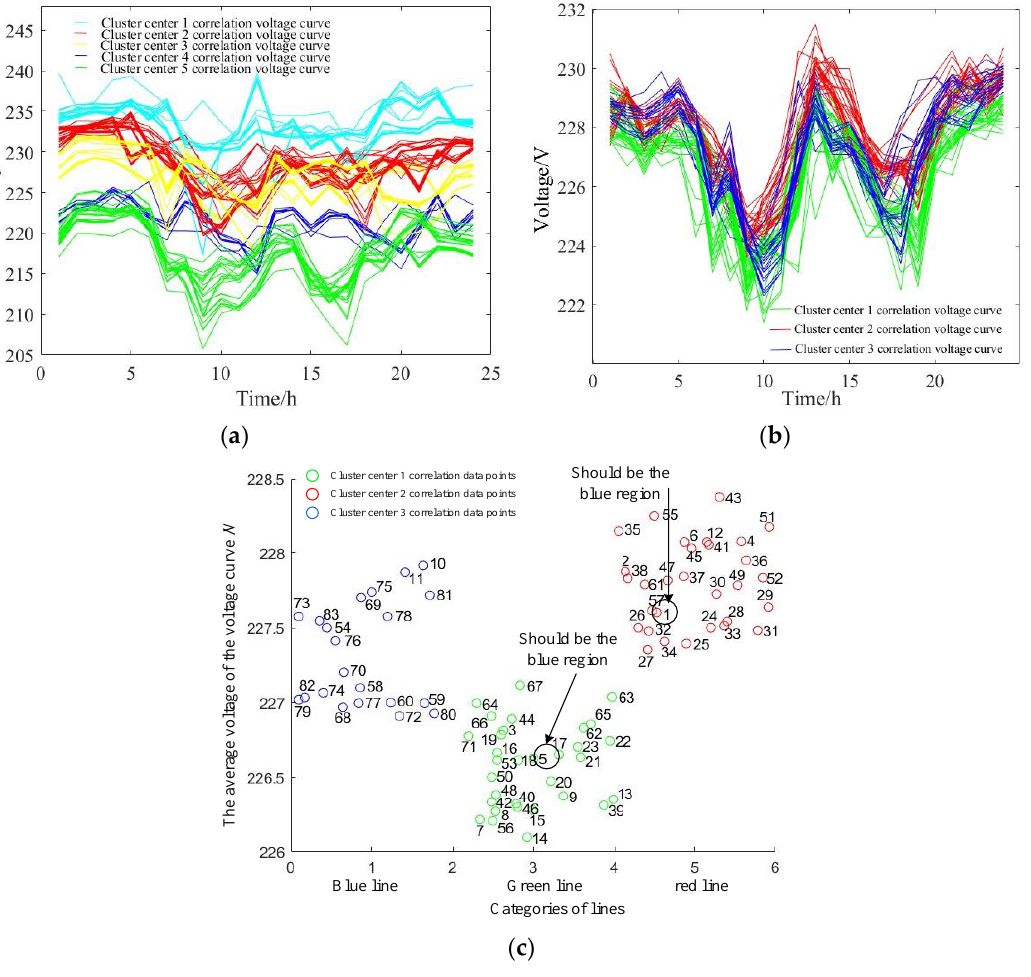
Figure 10. Analysis chart of voltage data in the missing region of the station area: ( a ) Voltage variation curve of users in the missing area after clustering in station A; ( b ) Voltage change curve of users in the missing region after clustering; ( c ) User distribution map of missing region after clustering.